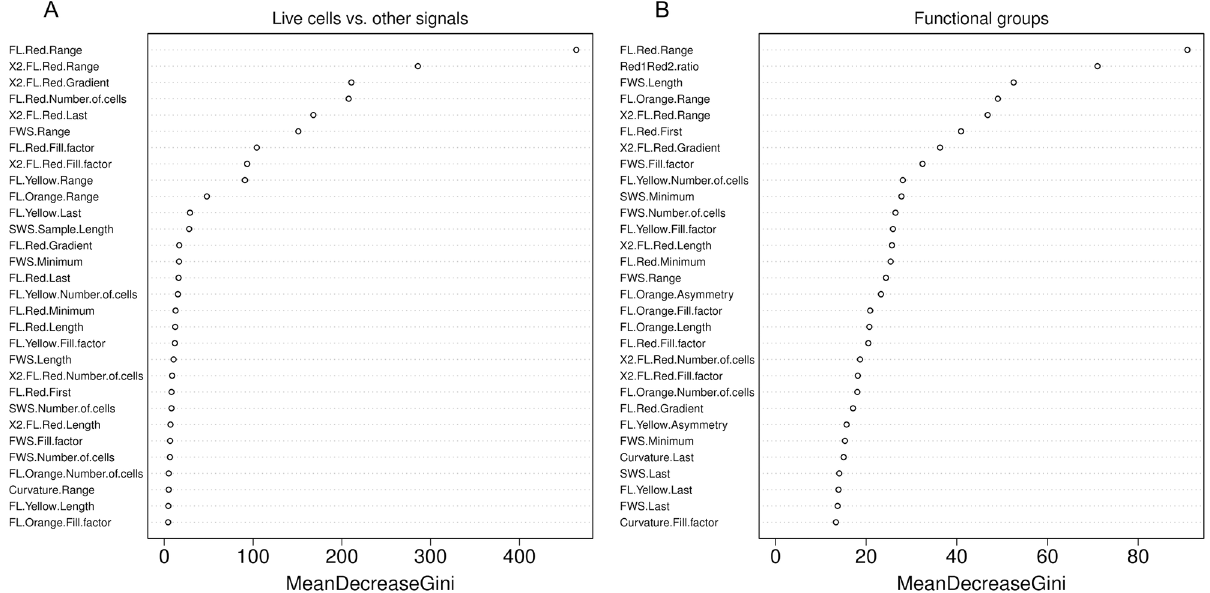
Fig 2. Importance of different traits in distinguishing between particle types, as identified by random forests. We applied random forests to laboratory training data (S2 Fig) to identify the most important variables in separating particule types. Variable importance is assessed using a Gini coefficient that measures the change in classification error when a variable is omitted [27]. The 30 most important variables are shown here. A) Variables that most strongly distinguish between live cells and other signals (electronic noise, detritus and bacterial cells). The top ten were used for unsupervised clustering of the raw field data. B) Variables that most strongly distinguish between major functional groups. The top eight were used for unsupervised clustering of the cleaned field data.